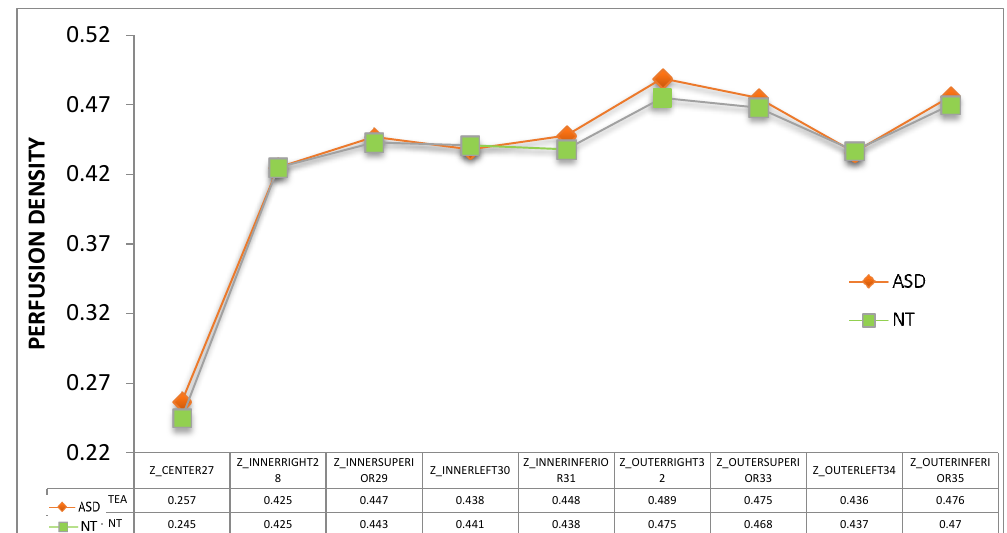
Figure 10. Perfusion density of the nine subfields of the macular ETDRS grid. ASD = autism spectrum disorder group; NT = neurotypical group. Mean values were indicated for each group. No significant differences were detected between groups (Mann–Whitney U test).